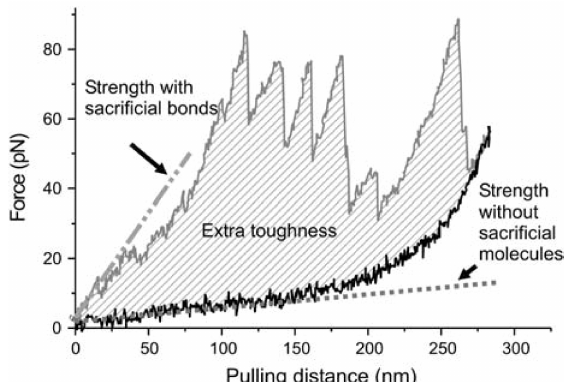
Figure 2. Sacrificial bonds increase the toughness of a material. The extra-energy (or extra-toughness) adsorbed and dissipated through the sacrificial molecules (shaded area in the curve) is a measure of the increase in toughness of the material. Moreover, the initial slope of the pulling curve can be modified by the sacrificial bonds (dash–dotted line with the sacrificial bonds and dotted line without the sacrificial bonds). We can also see the sawtooth pattern of the force–extension response. Reprinted with permission from Reference [3]. Copyright 2006